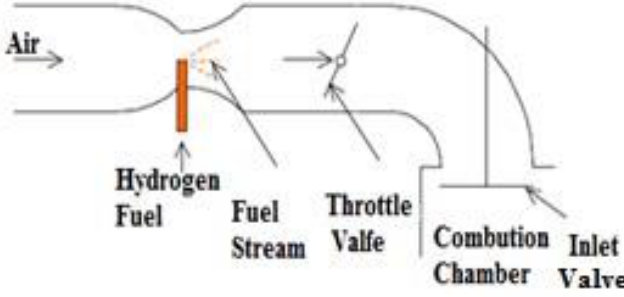
Figure 3. Fuel carburetion technique in action [65].